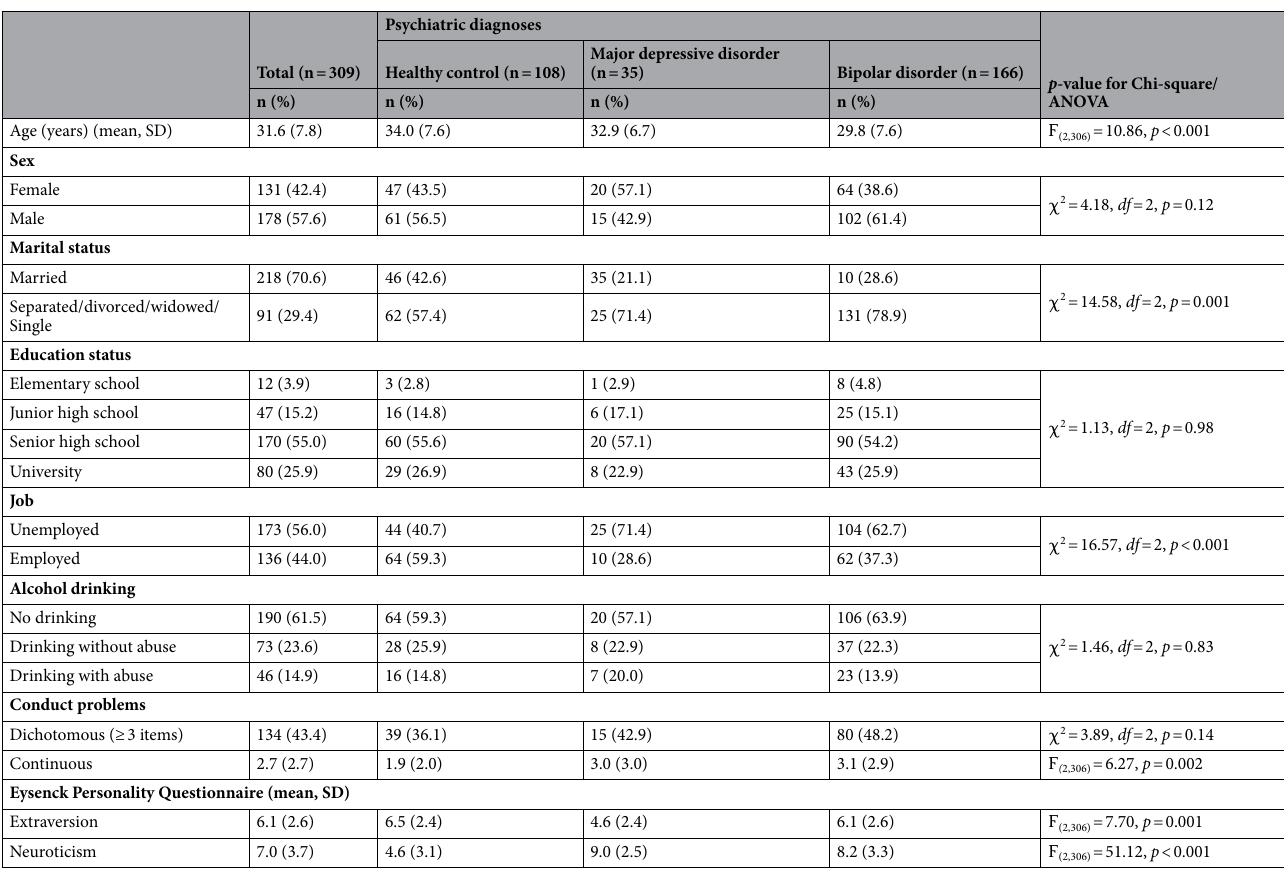
Table 1. Comparisons of sociodemographic and clinical characteristics by psychiatric diagnoses (n =